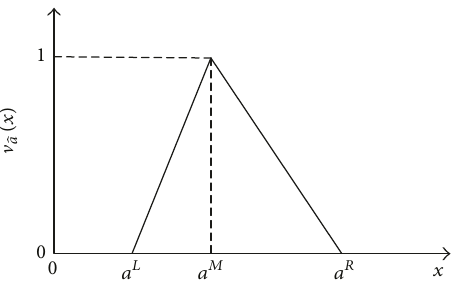
Figure 3: The framework of the proposed method.